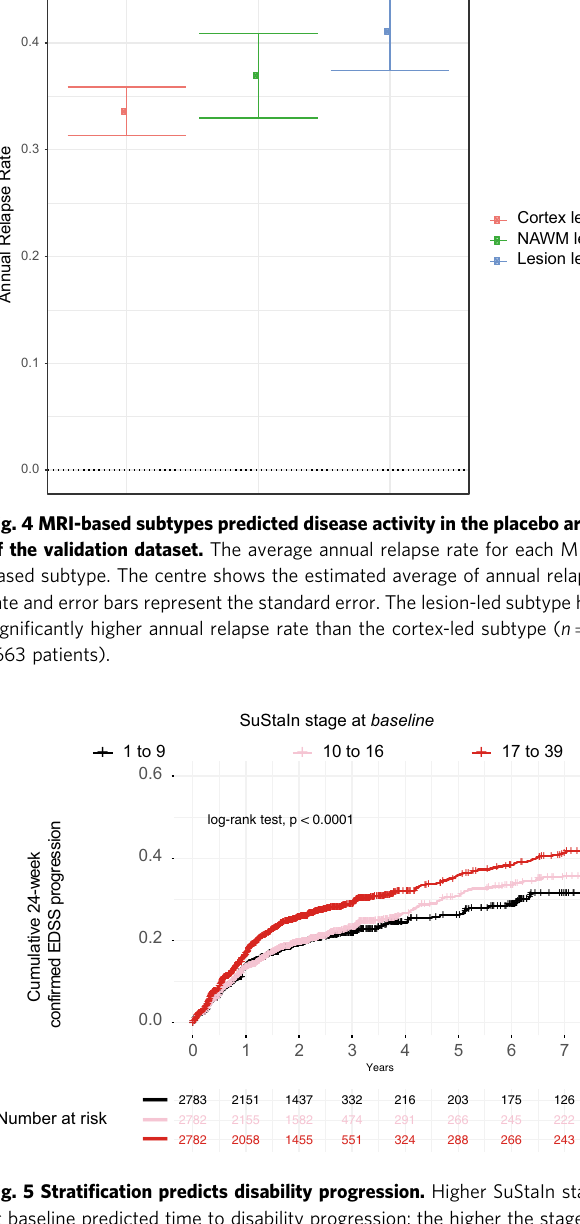
Fig. 5 Strati fi cation predicts disability progression. Higher SuStaIn stage at baseline predicted time to disability progression: the higher the stage at baseline, the shorter the time to reach 24-week con fi rmed EDSS progression. p -Value is two-sided ( p < 0.0001). When we repeated this analysis inside each MRI-based subtype we found similar results (results not shown). EDSS expanded disability status scale.